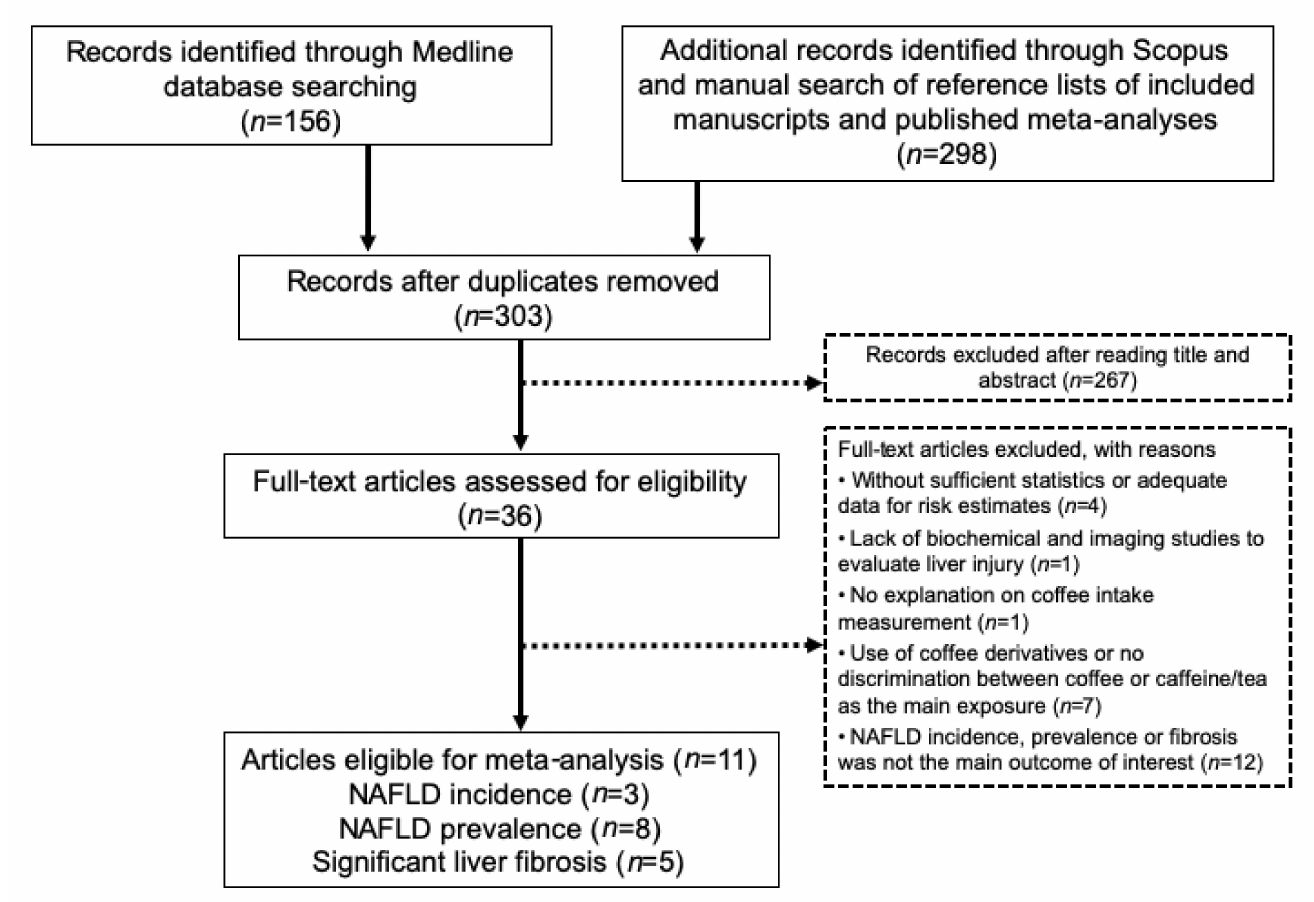
Figure 1. Flow chart of literature search and inclusion of studies in the meta-analysis. Abbreviation: NAFLD, Non-alcoholic fatty liver